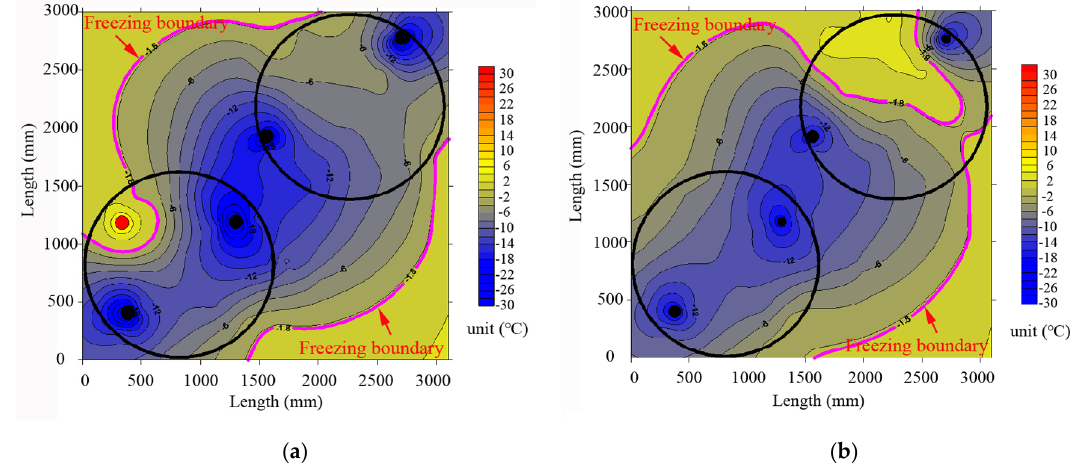
Figure 13 . The effect of controlling freeze (after being controlled for 17 days). ( a ) Heat control mode; ( b ) Cold control mode. ( b ) Cold control